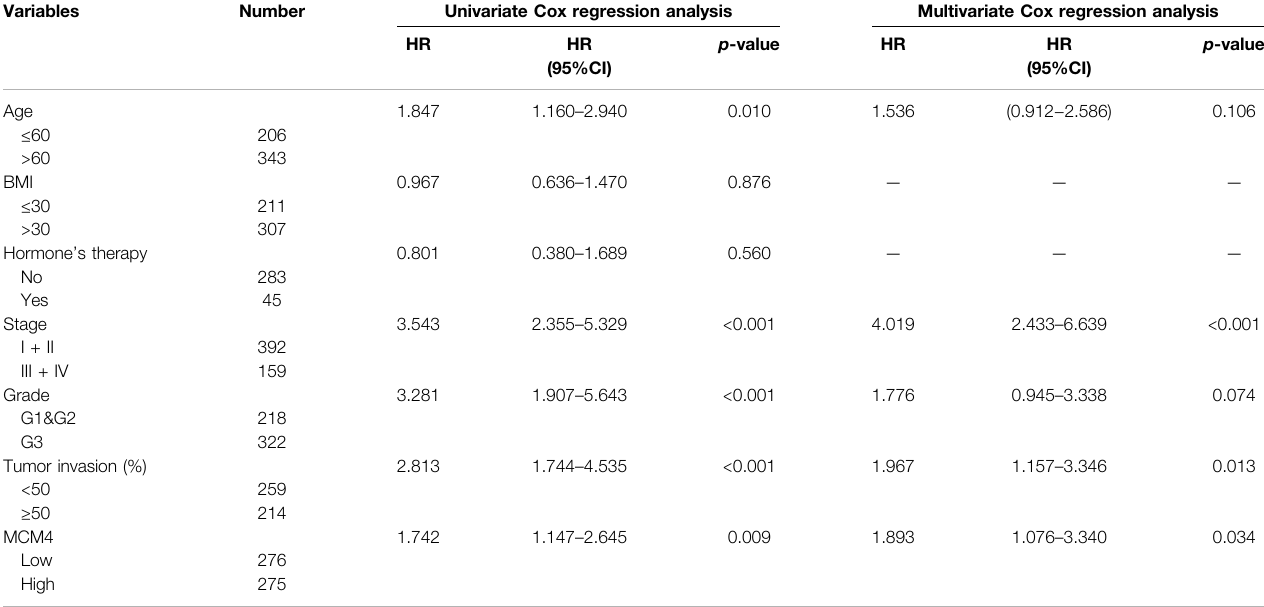
TABLE 1 | Independent prognostic analysis in UCEC.